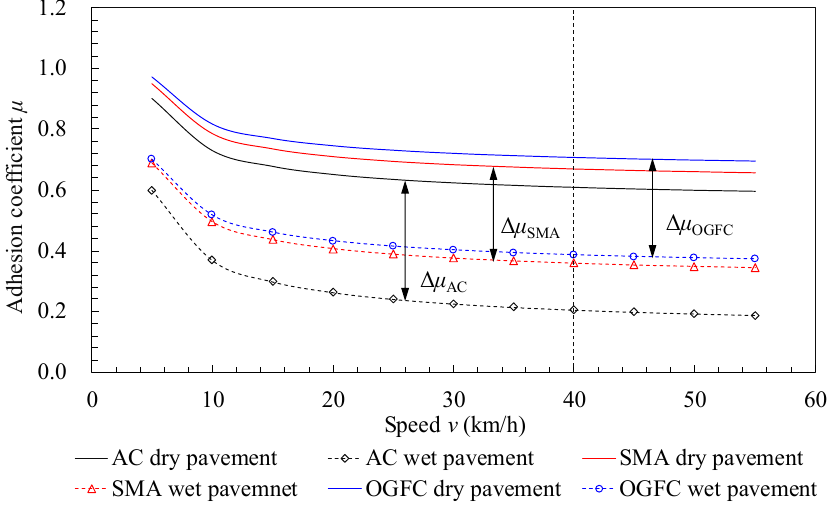
Figure 4. Variation of adhesion coefficient curves with tire speed.